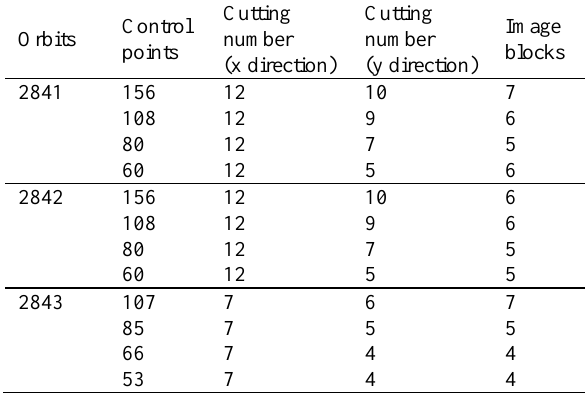
Table 1. IIM images of each orbital data segmentation